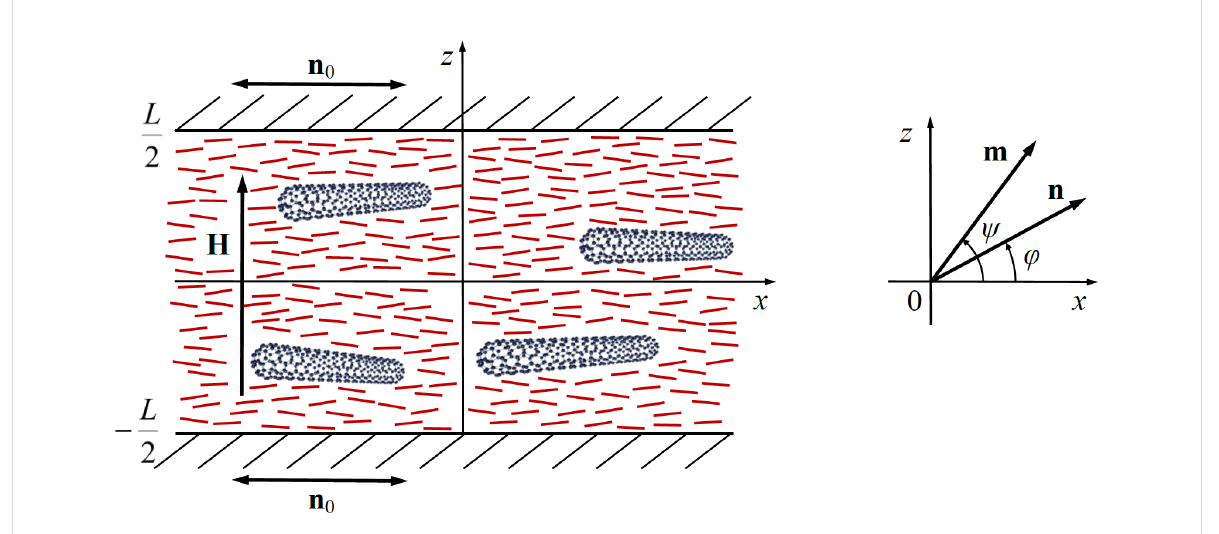
Figure 1: An NLC layer with CNTs in a magnetic